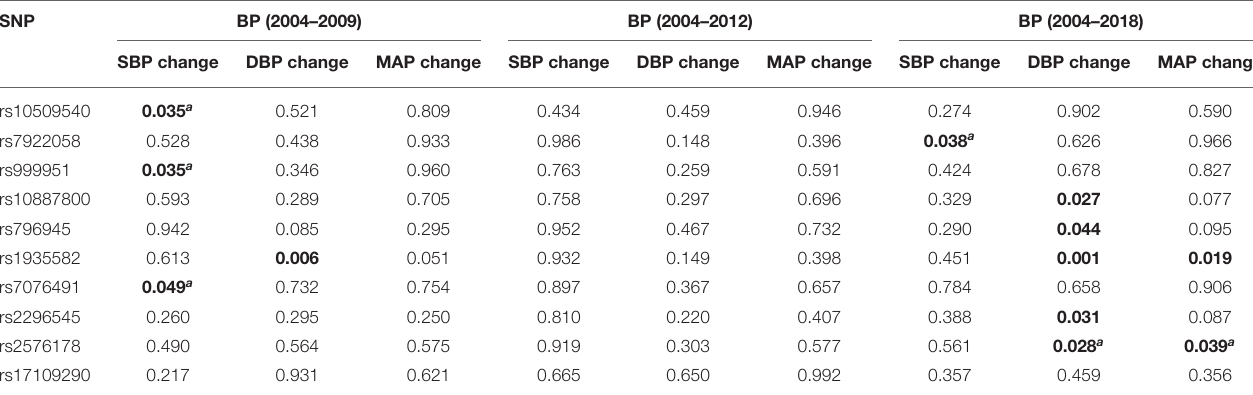
TABLE 2 | Association of RNLS SNPs with blood pressure changes from baseline to the